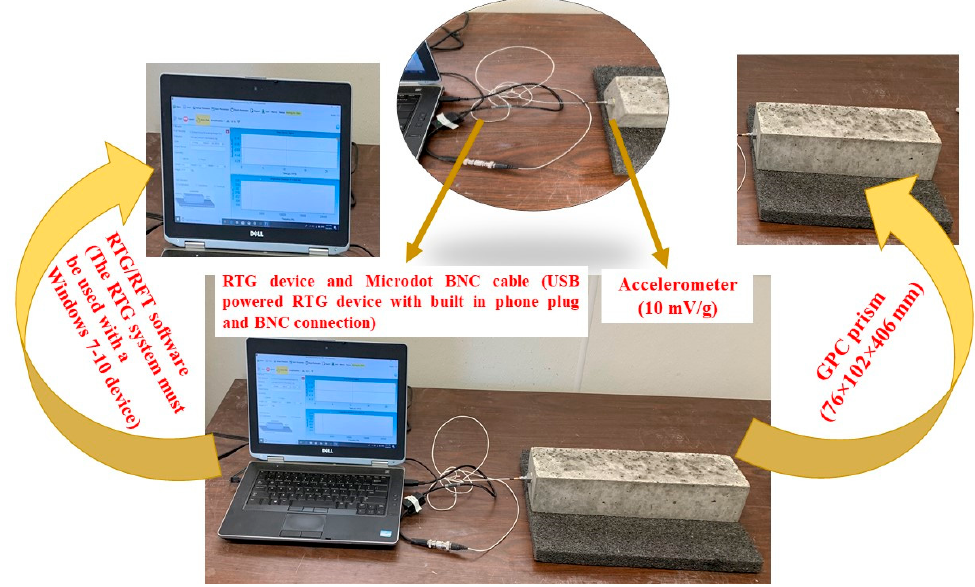
Figure 4. Resonant Frequency Test (RFT)/Resonant Frequency Gauge (RTG) Device.